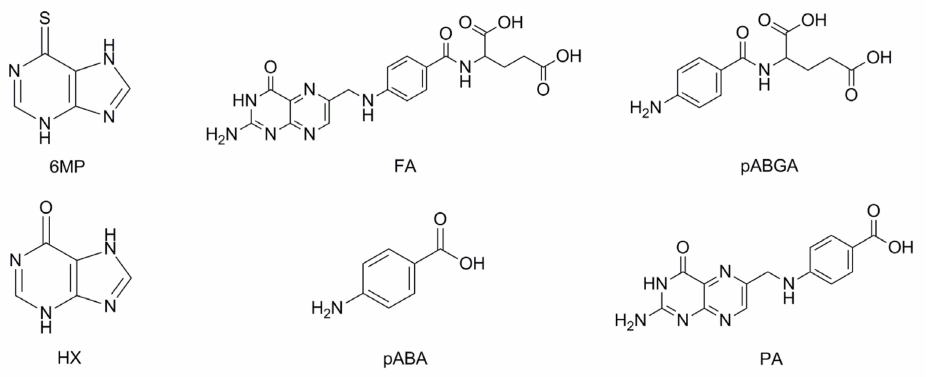
Figure 1. Structures of 6-mercaptopurine (6MP), folic acid (FA) and their selected